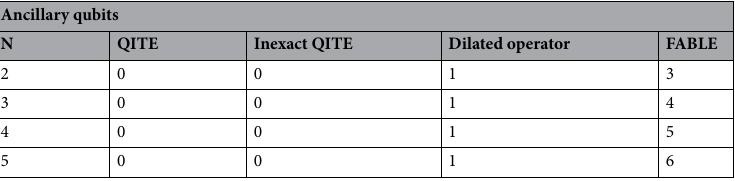
Table 2. Ancillary qubit requirement at various system sizes N for approximating the imaginary time evolution step of TPQ state preparation with the QITE, inexact QITE, dilated operator, and FABLE algorithms at β = 1 .